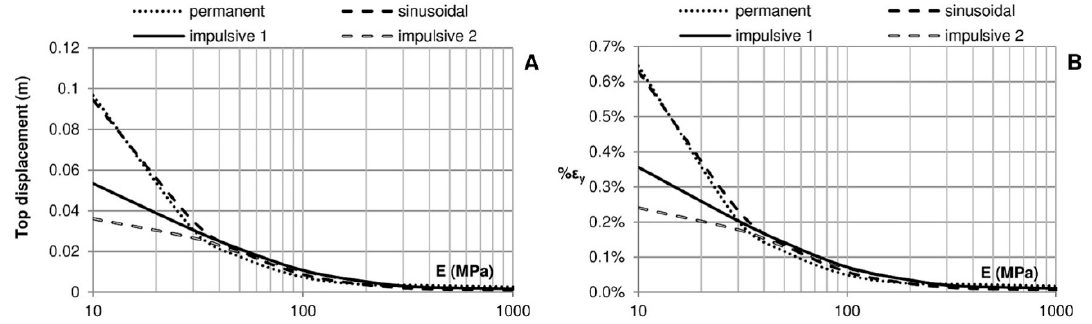
Figure 13. ( A ) Residual movement on the top of the crown wall; ( B ) residual vertical deformation.